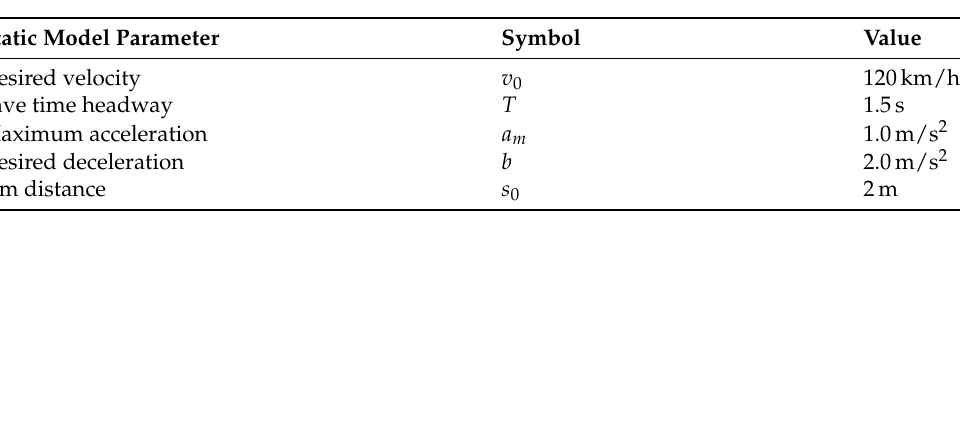
Table 1. Static model parameters used in the proposed approach for increasing the safety of ACC